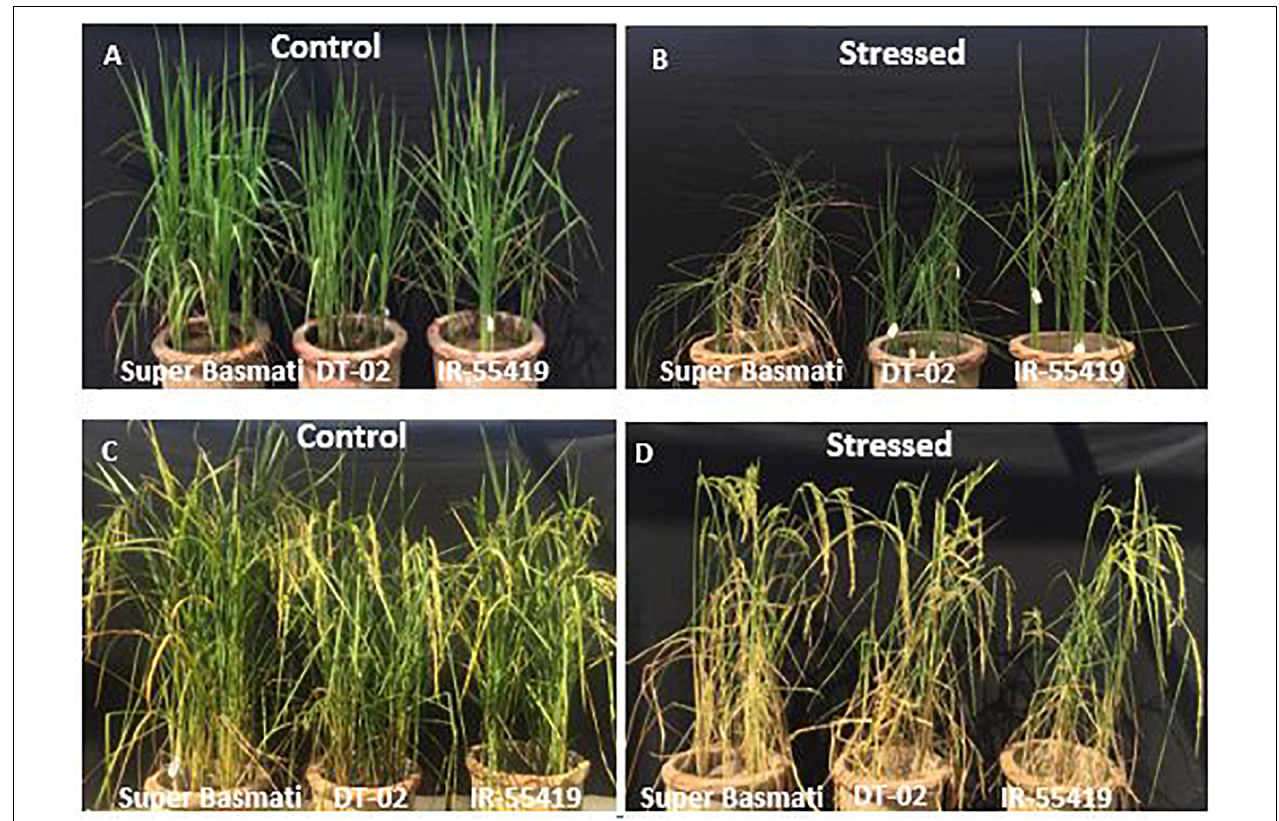
FIGURE 3 | Pictorial view of water stress treatments to rice genotypes during early and later growth stages under net house conditions. Genotypes: SB, IR-55419, and DT-02. (A) Control-well irrigated rice plants till 30 days after transplantation (DAS). (B) Stressed-water stress rice plants (water withholding for 15 days after